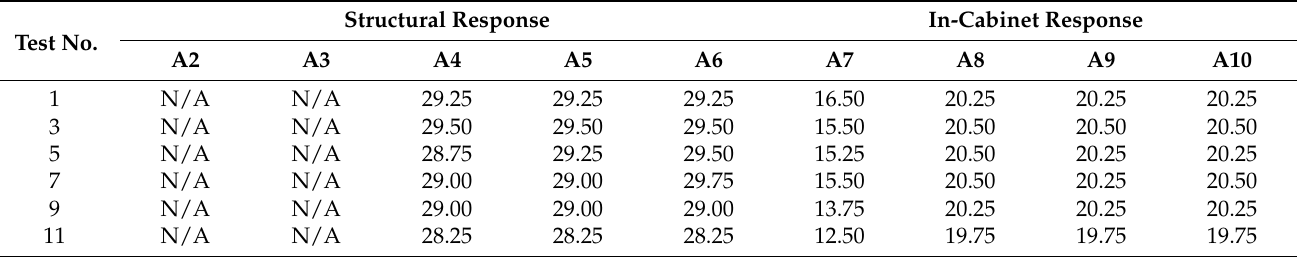
Table 4. Summary of front-to-back resonant-frequency test.